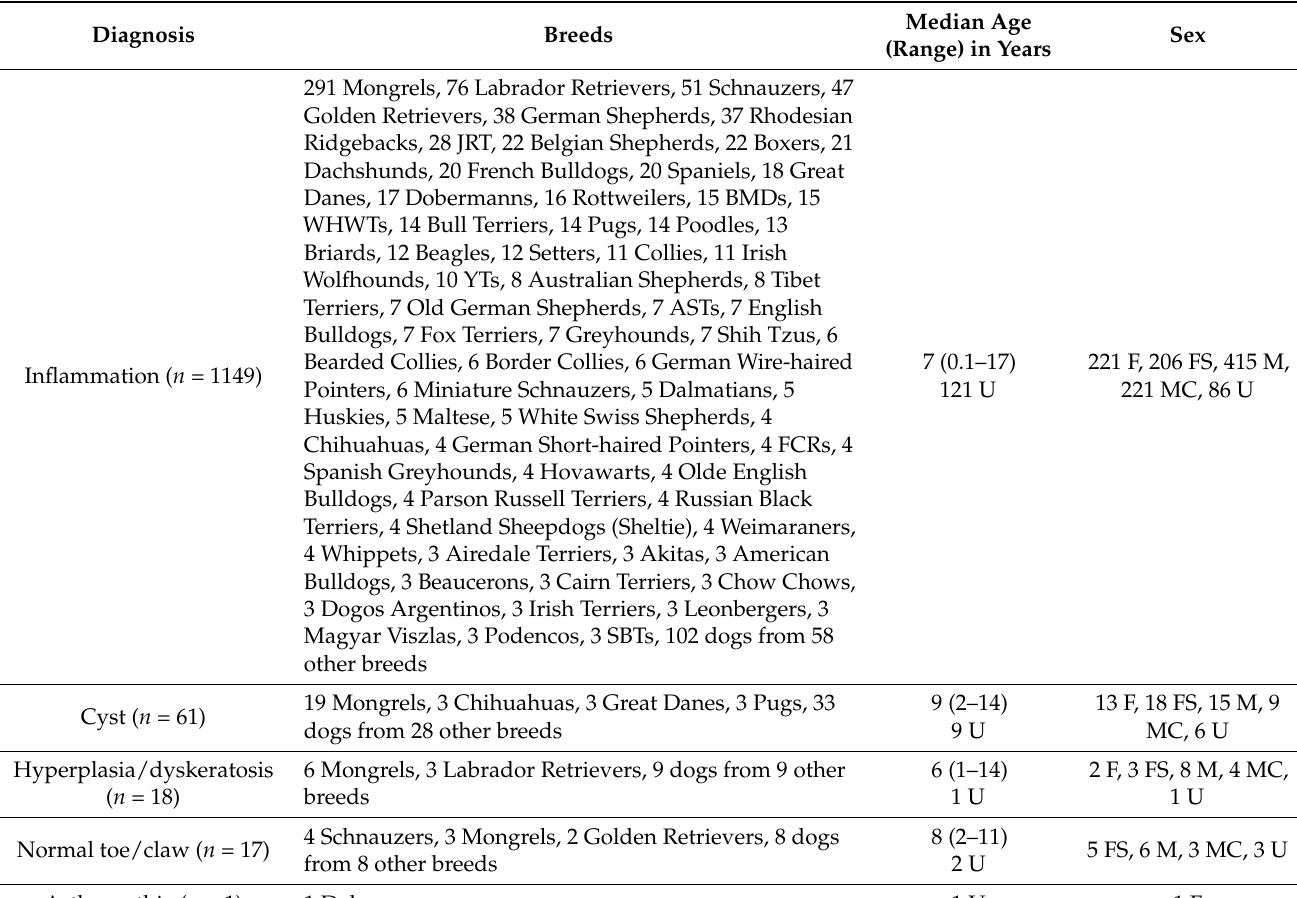
Figure 4. Histological pictures of normal and neoplastic canine toes. ( A ) Normal longitudinal cut through phalanx I of the toe of a 6-year-old Kerry blue Terrier with inflammation in the paw pad (Hematoxylin-Eosin (HE), bar = 1000 µm); ( B ) subungual keratoacanthoma of a 10-year-old English Setter (HE, bar = 250 µm); ( C ) squamous cell carcinoma of a 12-year-old giant Schnauzer (HE, bar = 100 µ m); ( D ) apocrine Carcinoma of a 9-year-old Mongrel (HE, bar = 100 µ m); ( E ) soft tissue sarcoma of a 9-year-old Dalmatian (HE, bar = 200 µ m); ( F ) acral malignant melanoma of a 9-year-old Labradoodle (HE, bar = 200 µ m). Table 1. Signalment of the 1246 dogs with non-neoplastic lesions (group 1).